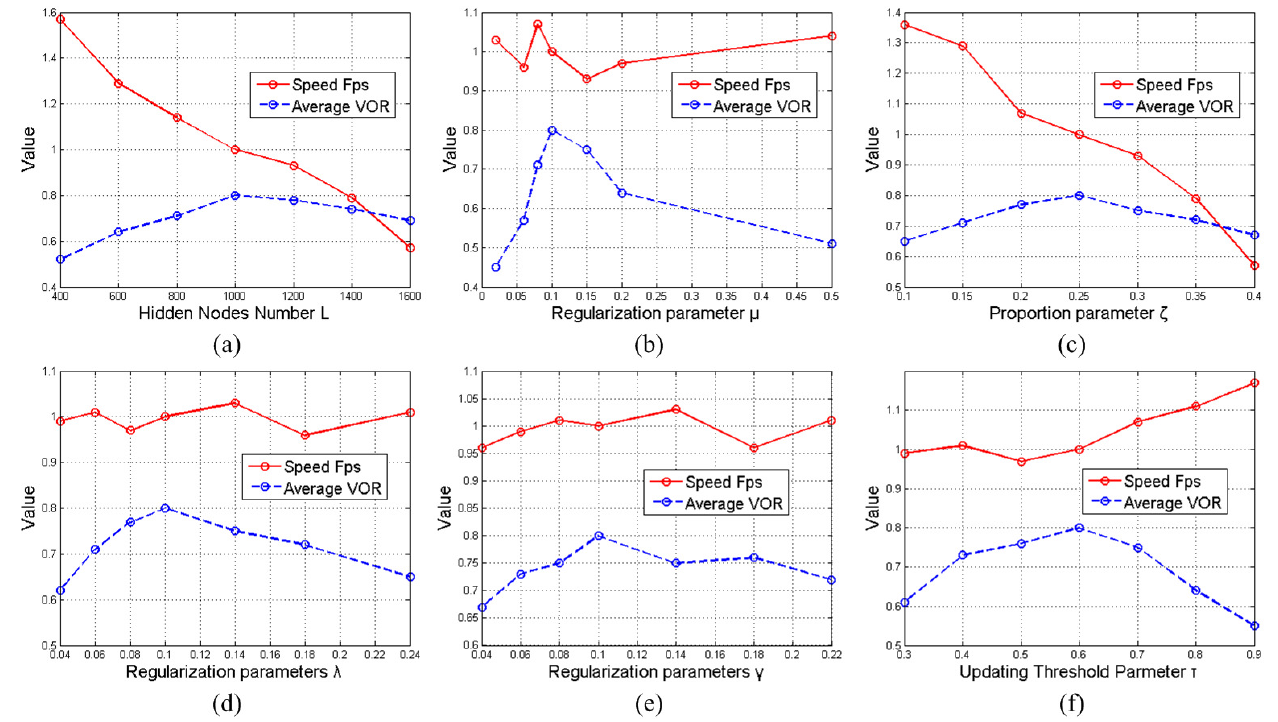
Figure 3. The effects of parameters: ( a ) L , ( b ) µ , ( c ) ζ , ( d ) λ , ( e ) γ , ( f ) τ